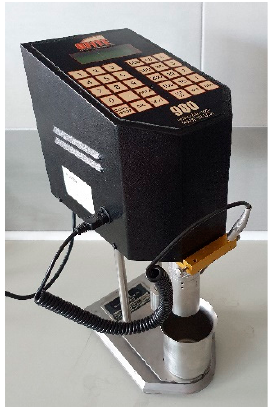
Figure 2. Fann model 900 rotary viscometer.